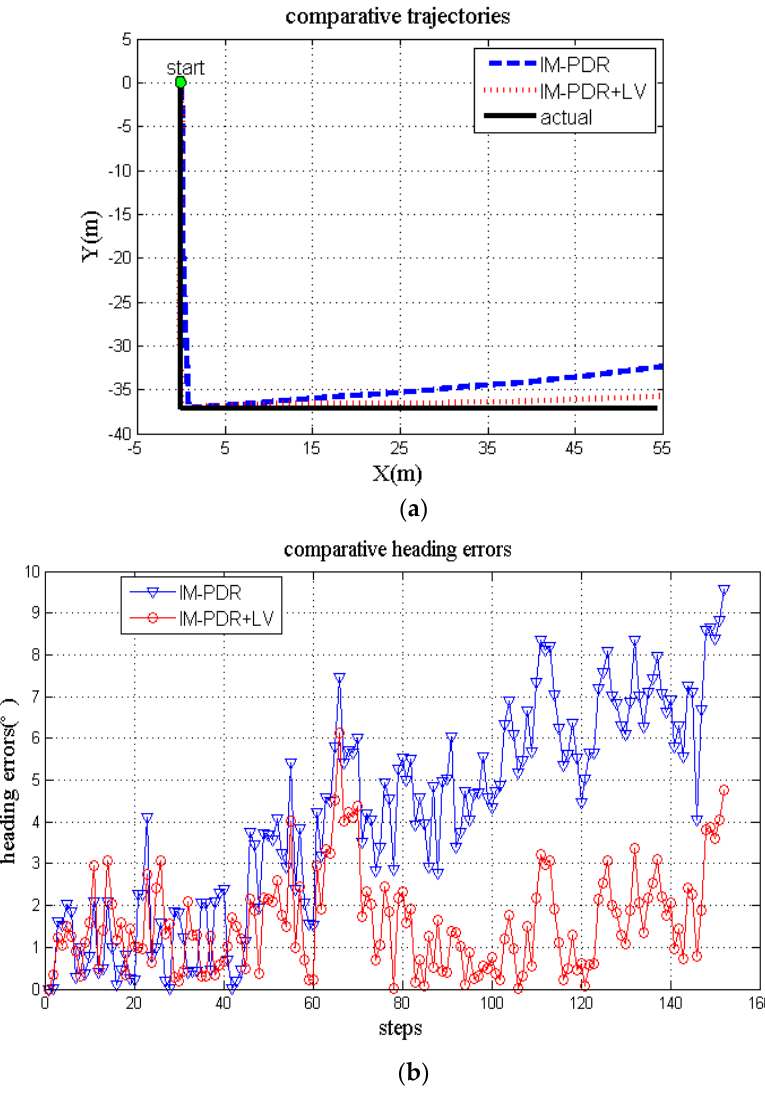
Figure 9. Results of straight line test: ( a ) comparative trajectories; ( b ) comparative heading errors.